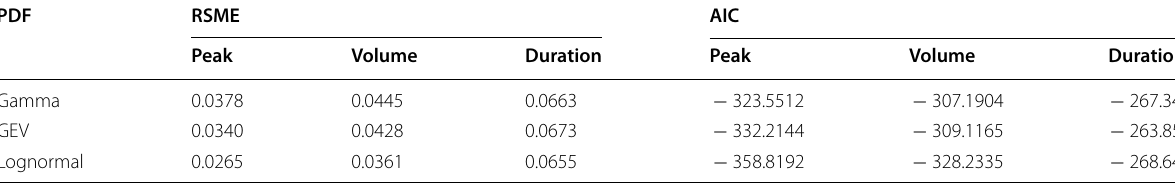
Table 4 Comparison of RMSE and AIC values of flood variables for different statistical distributions PDF RSME AIC Peak